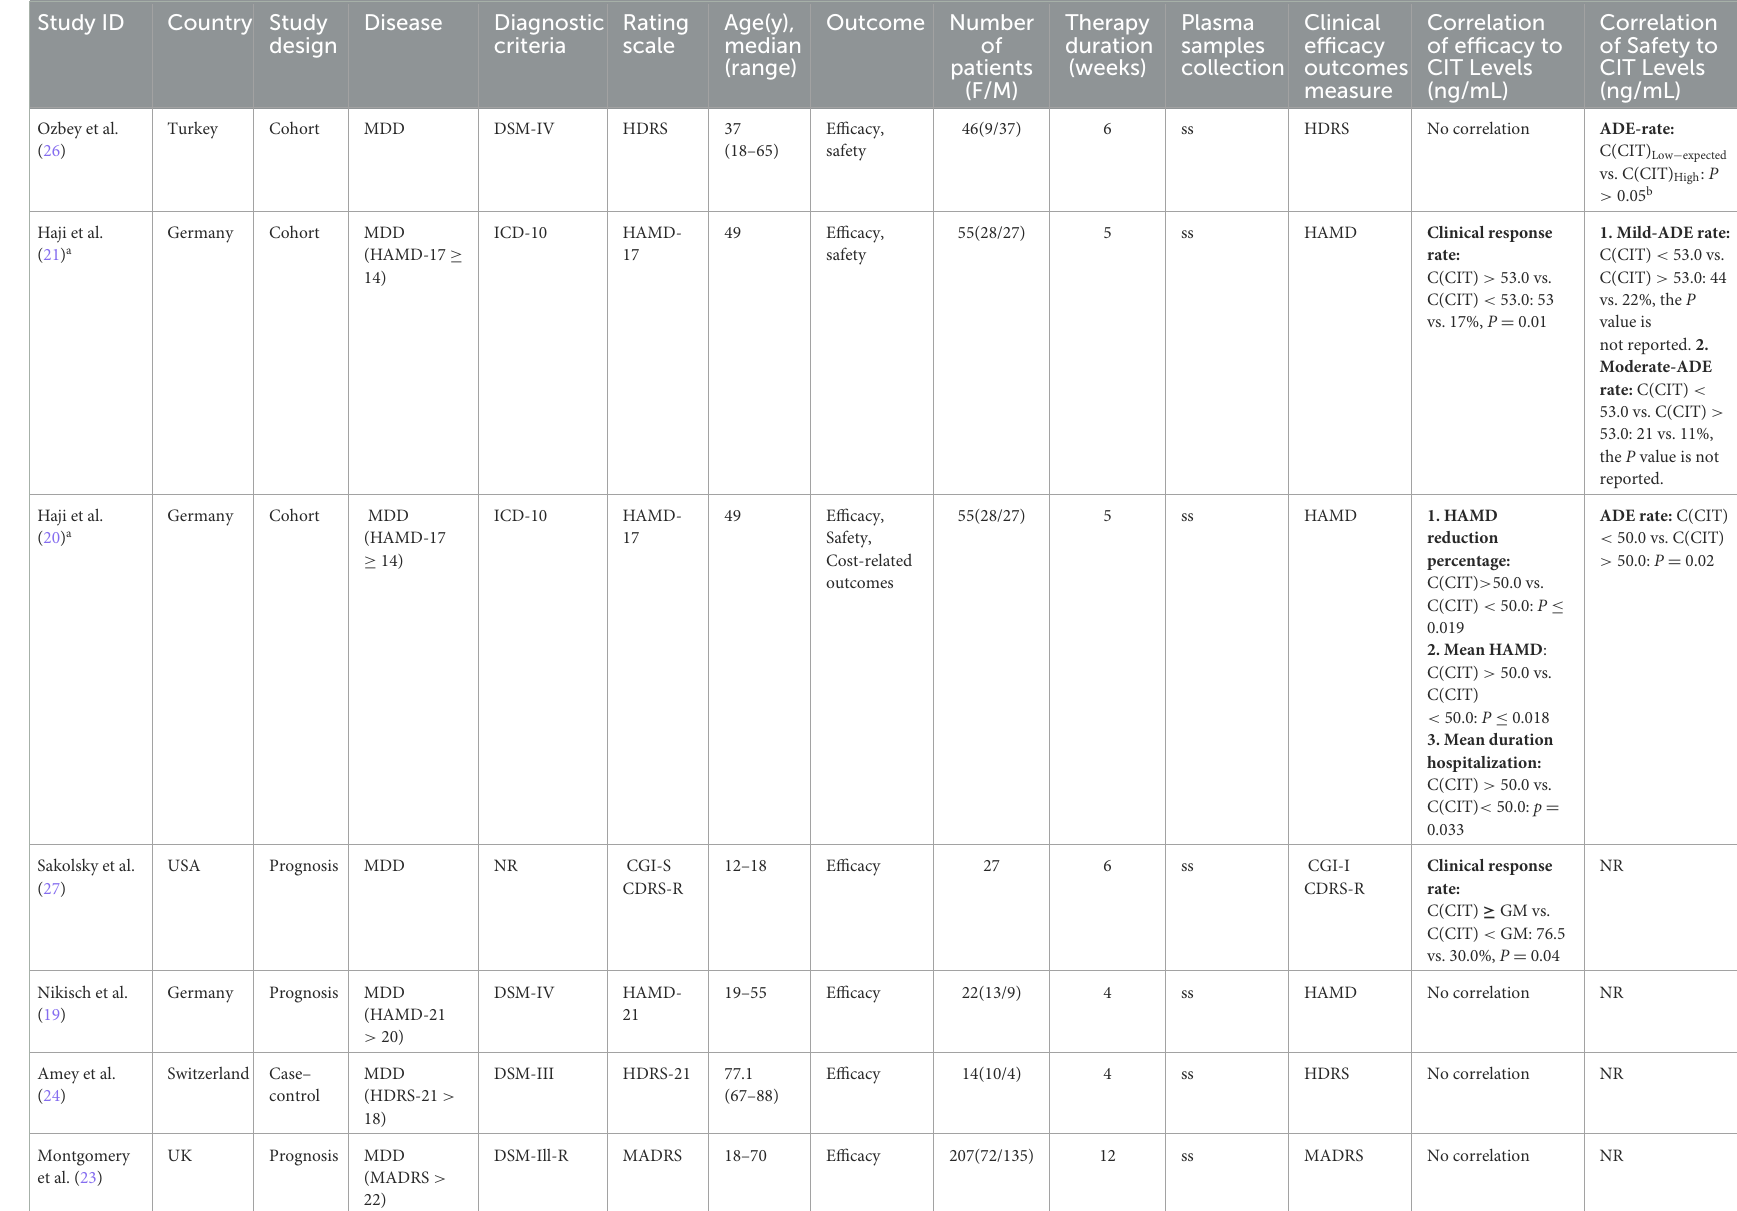
TABLE 1 Main characteristics of the studies